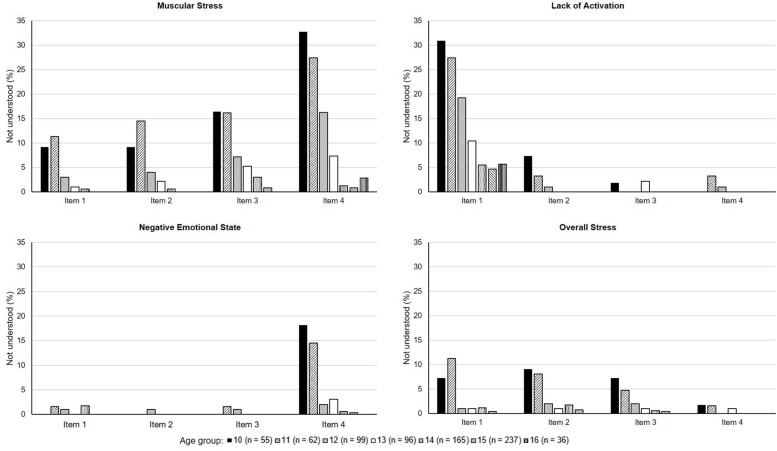
Percentages of items that were not understood within the Stress dimension separated by age subgroups of phase 2.